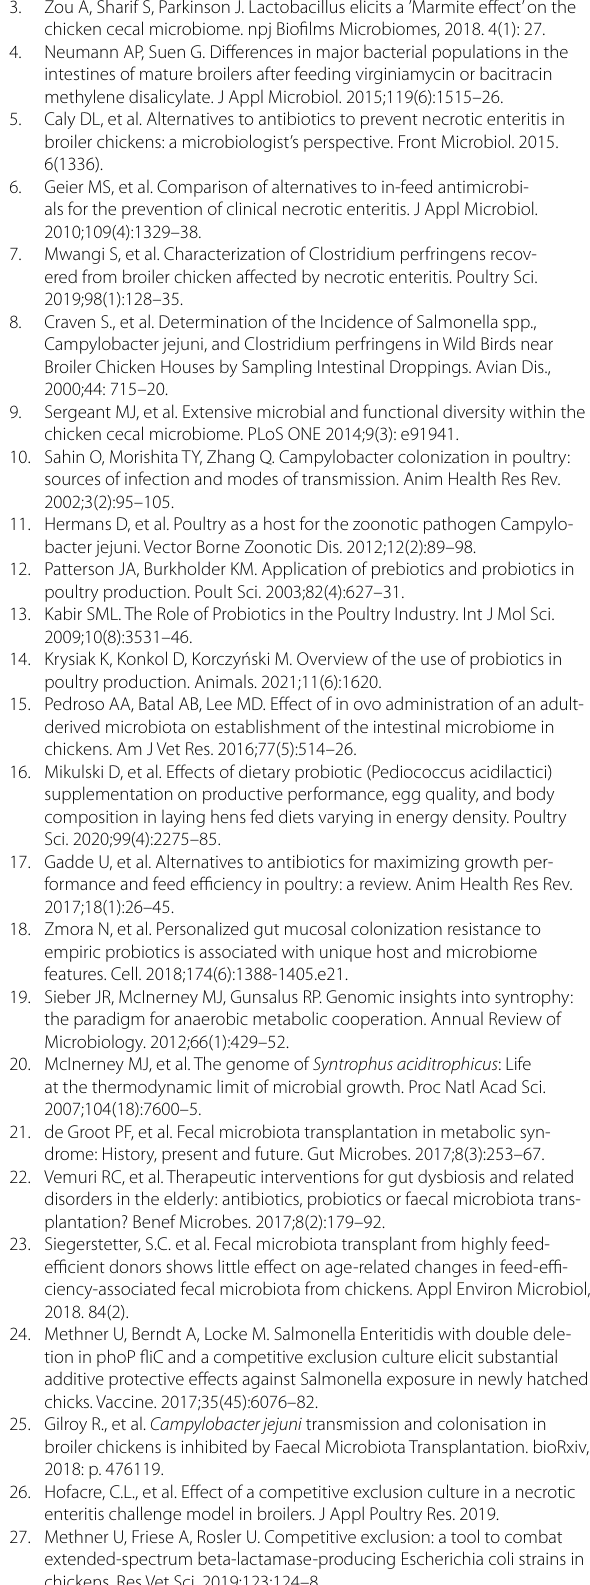
represented in green and red coloured bars respectively. OTUs are further grouped by their assigned taxonomic families. Legend lists taxonomic families in order of appearance. (B) Vertical bars in the UpSet plot visualizes the number of OTUs unique to each treatment group and the number of OTUs shared between treatment groups at 30 days post‑hatch. Horizontal bars represent the total number of OTUs found in each